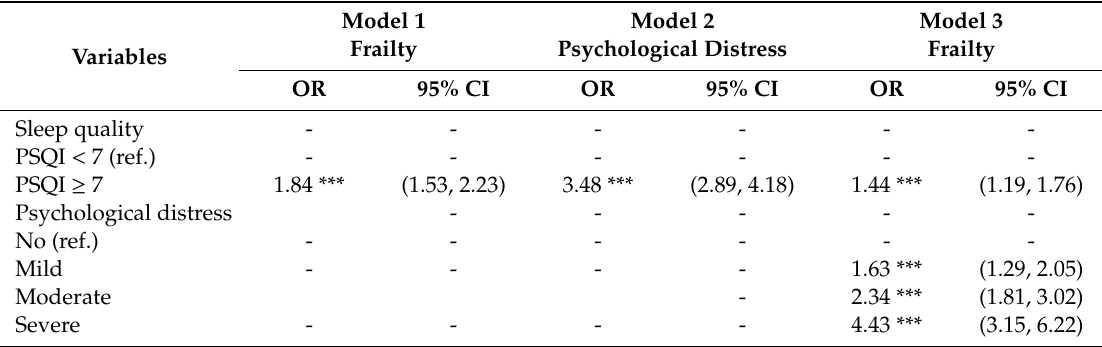
Table 2. The mediating e ff ect of psychological distress on the association between sleep quality and frailty among elders with chronic diseases ( n =